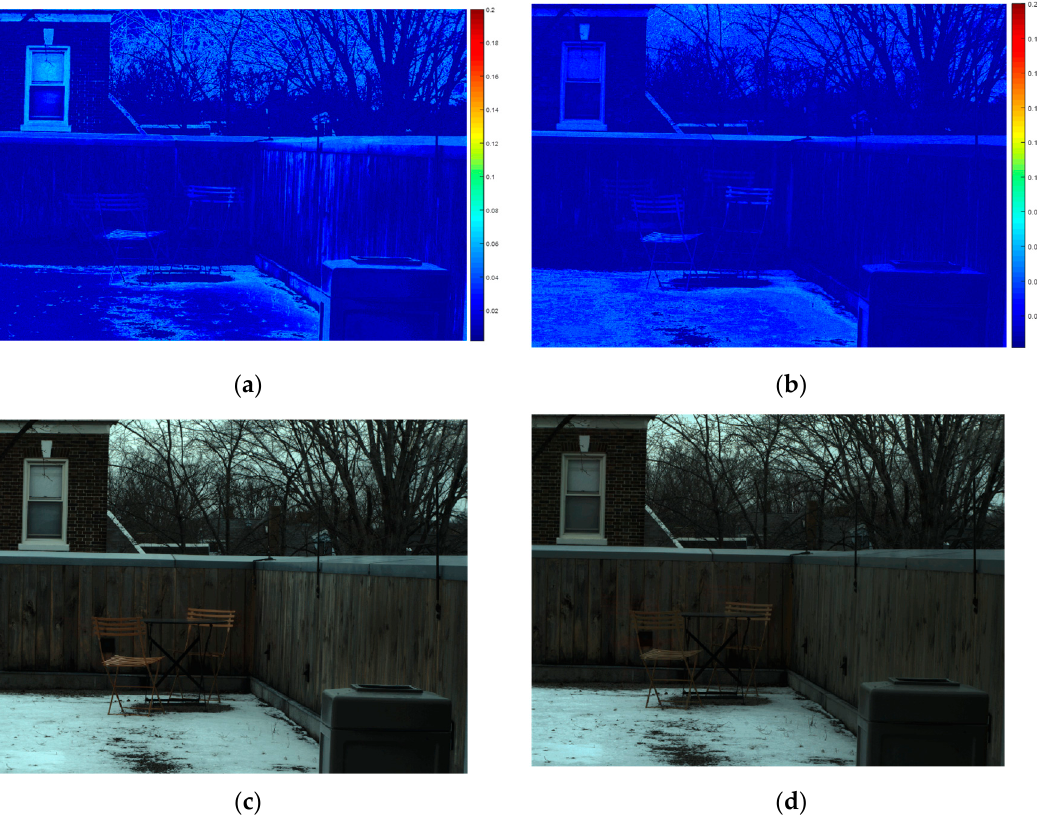
Figure 6. Example of per-pixel RMSE images and reconstructed RGB images of high-resolution HSIs: ( a ) Per-pixel RMSE image where a shear transformation with C x = 0.3 is applied, ( b ) a per-pixel RMSE image where translation with P n = 80 is applied, ( c ) RGB image an where shear transformation with C x = 0.3 is applied, and ( d ) RGB image where translation with P n = 80 is applied.